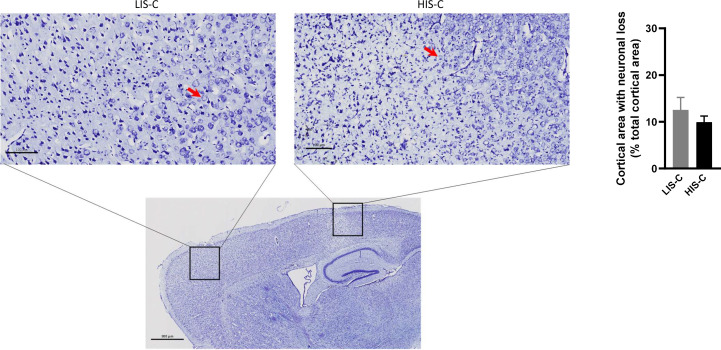
Neuronal loss evidenced by toluidine blue is similar in mice with high clinical score (HIS-C) and with low clinical score (LIS-C) after cytokine injection.Representative photomicrograph, close-ups and quantification of the area with decreased neuron density assessed with toluidine blue in the ipsilateral cortex of HIS-C and LIS-C mice. The red arrows point to a neuron nucleus. (The scale bar represents the indicated length. N = 8–10/group. Data are mean ± sem.